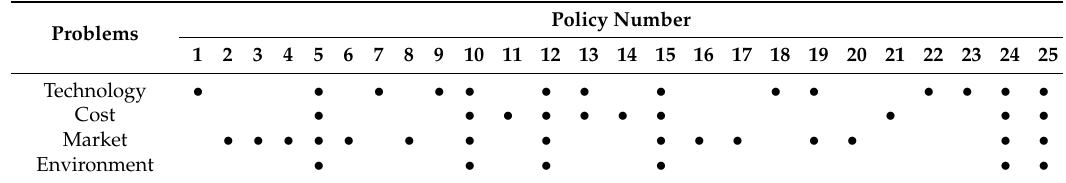
Table 2. The correspondence between policies and main problems.